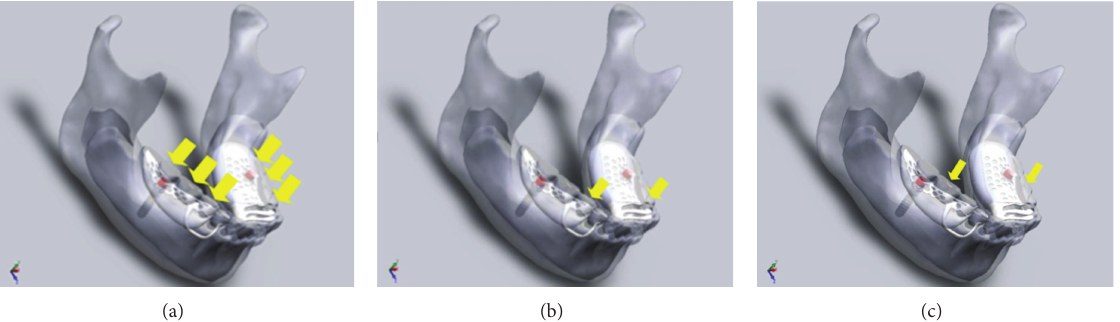
Figure 2: (a) Bilateral loading uniform; (b) bilateral loading premolar; (c) bilateral loading molar.